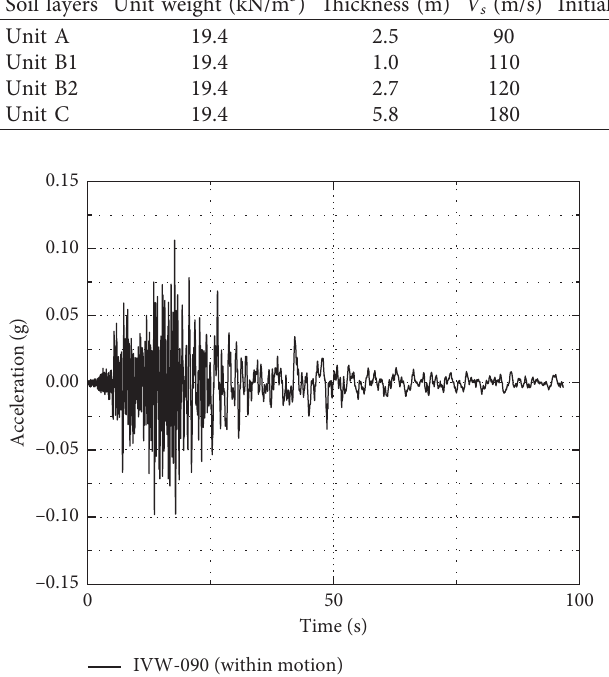
Figure 2: Input motions at the depth of 7.5m below the